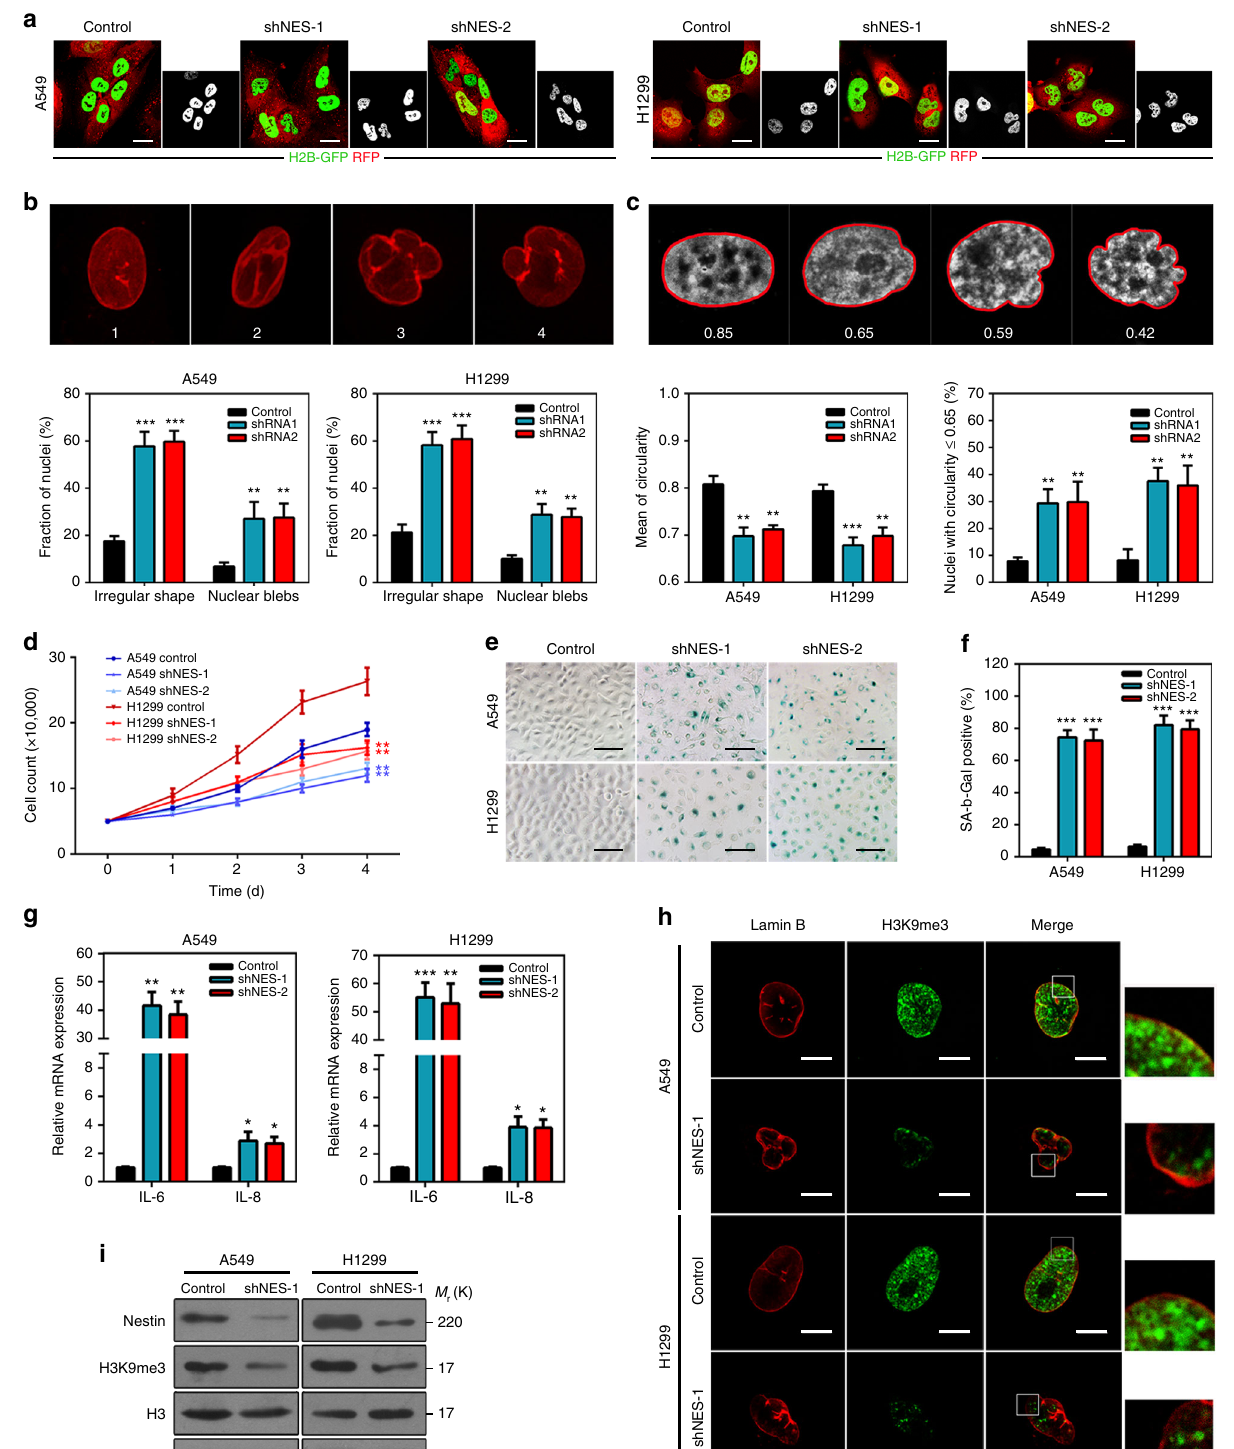
H1299 cell line with CRISPR/Cas9 system, which has been reported to ef fi ciently disrupt genes in various organisms 35 . Only one of the three designed guide RNAs (gRNAs) was able to mediate the ef fi cient introduction of indel mutations at its target site, as assessed using a previously described T7 endonuclease 1